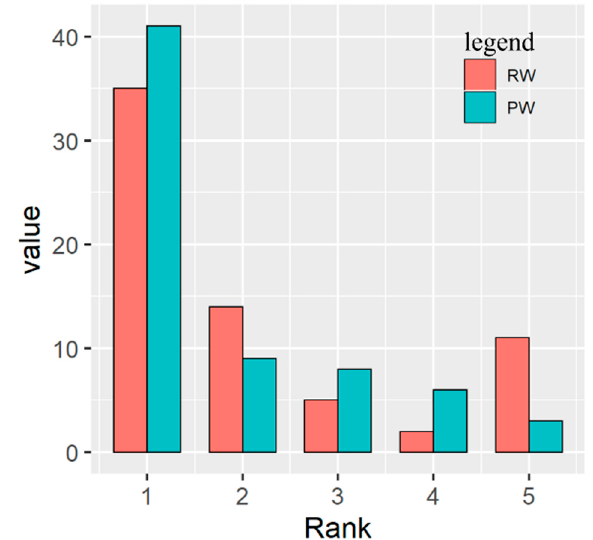
Figure 4. Classification of drinking water quality based on the water quality index (WQI): number of raw water (RW) and purified water (PW) samples with ranks of 1 to 5 (Table 1).